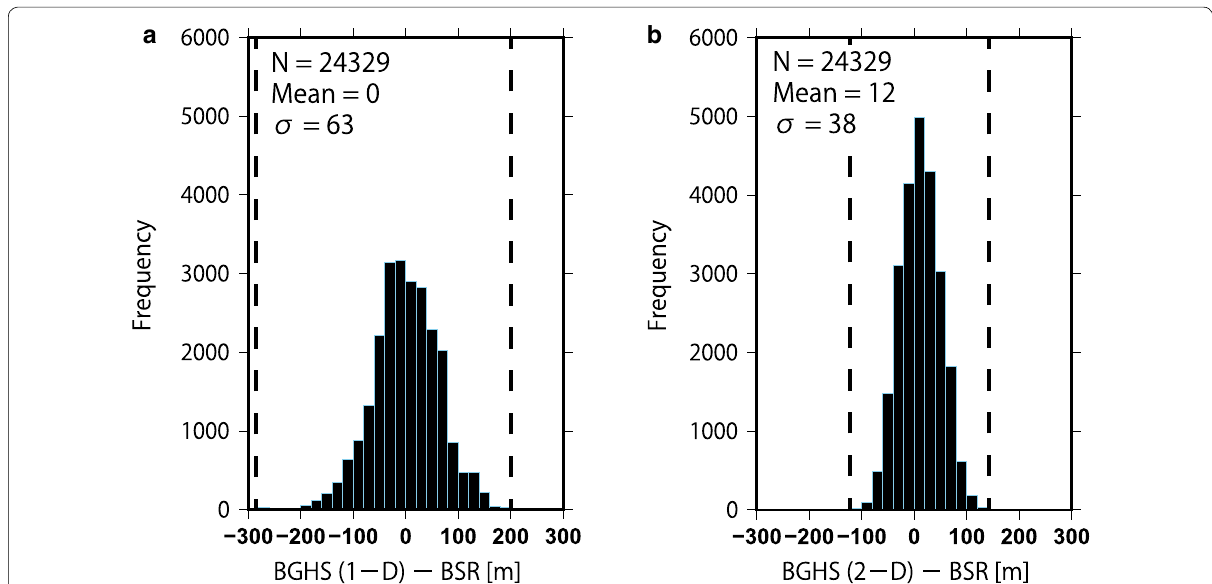
Fig. 11 Differences between the BGHS and BSR depths, compiled from 21 seismic profiles (24,329 points). a Differences between the one-dimen- sional BGHS depths without considering the topographic effect and the BSR depths. The differences range from and the standard deviation are 0 and 63 m, respectively. b Differences between the two-dimensional BGHS depths considering the topographic effect and the BSR depths. The differences range from